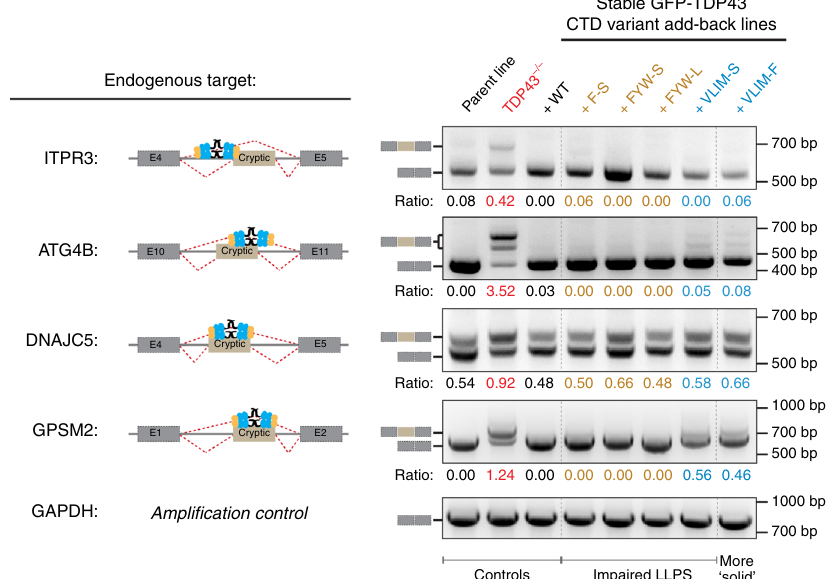
Fig. 8 LLPS-de fi cient TDP43 supports exon skipping in endogenous genes. Splicing of cryptic exons in ATG4B, DNAJC5, GPSM2 , and ITPR3 known to be regulated by TDP43 was assessed in WT, TDP43 − / − , or TDP43 − / − HEK-293T cells stably expressing the indicated variants of GFP-TDP43. See Supplementary Fig. 8 for characterization of these cell lines, including estimation of nuclear GFP-TDP43 levels. Cartoons to the left show the position of the TDP43 binding site relative to the cryptic exon in each gene. Primers aligning to exons fl anking the cryptic exon were used in RT-PCR (gel on right) to assess the relative abundance of the mRNA species that either retained or excluded the cryptic exon. The expected PCR products for the correctly spliced transcripts are marked to the left of the gels. Numbers below each lane indicate the ratio of the exon-included to exon-excluded (i.e., correctly spliced) product GAPDH was used as ampli fi cation (Fig. 7b – d). Both TDP43 Δ NTD and TDP43 Δ CTD also showed